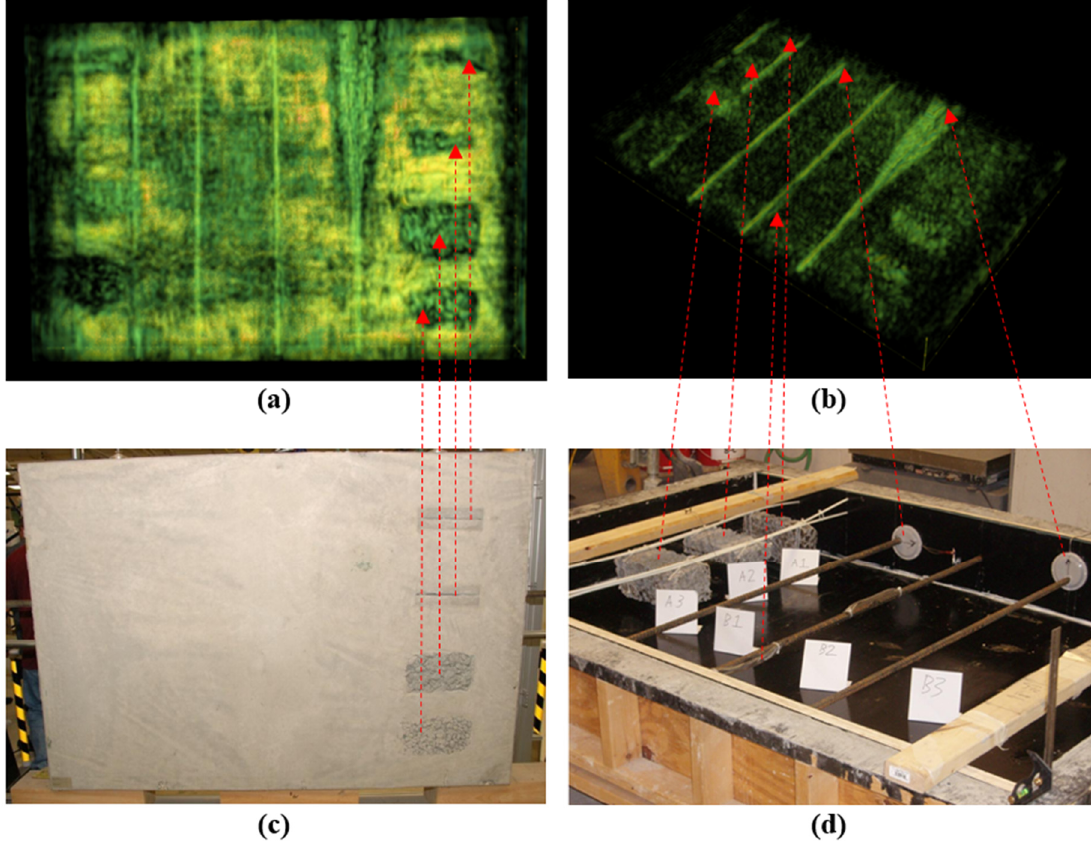
Figure 12. Imaging results for slab 6 from di ff erent view angles ( a , b ) versus ground truth ( c , d ).